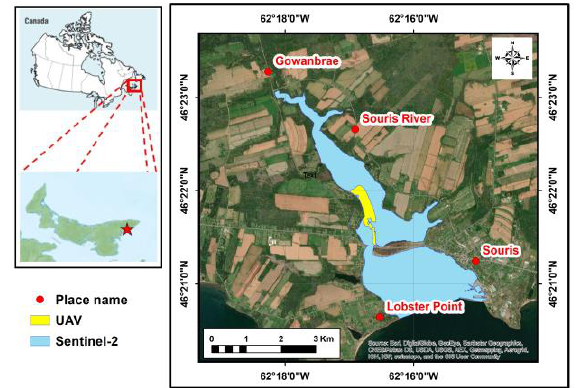
Figure 1. Location of the study area and limits of the area that was imaged by the Sentinel-2 imagery and the UAV imagery over a Google Earth image